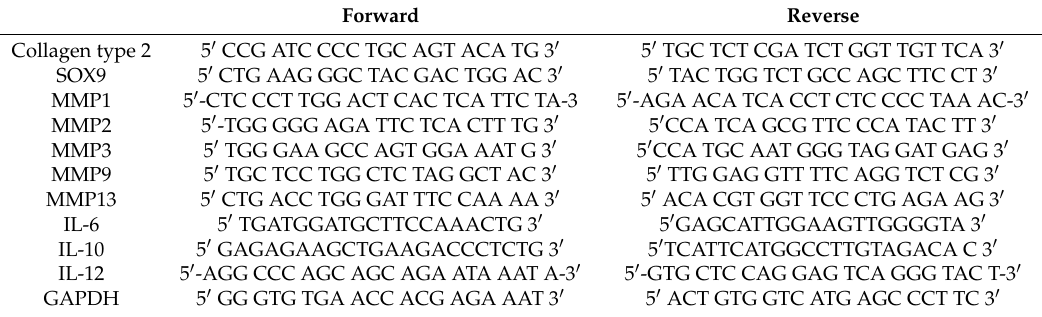
Table 1. Primer sequences utilized for real time RT-PCR evaluation of gene expression.